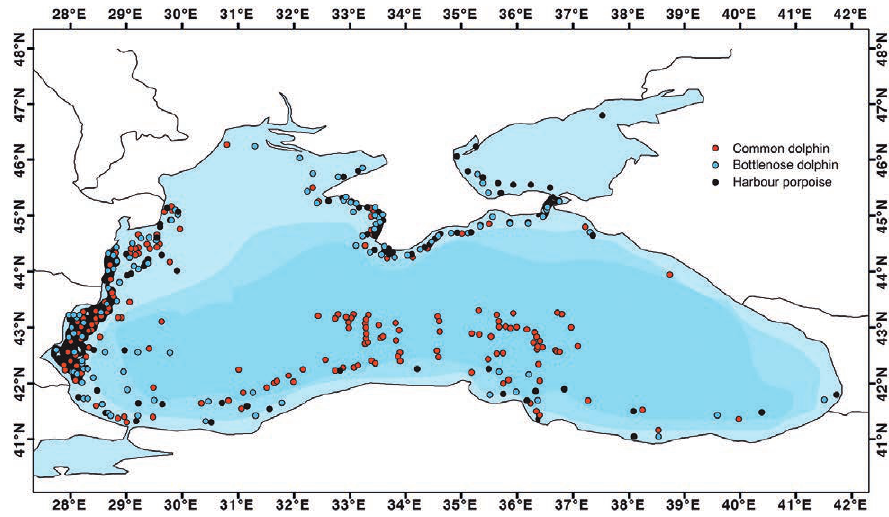
Fig. 1. – Visual sightings in the Black Sea between 1998 and